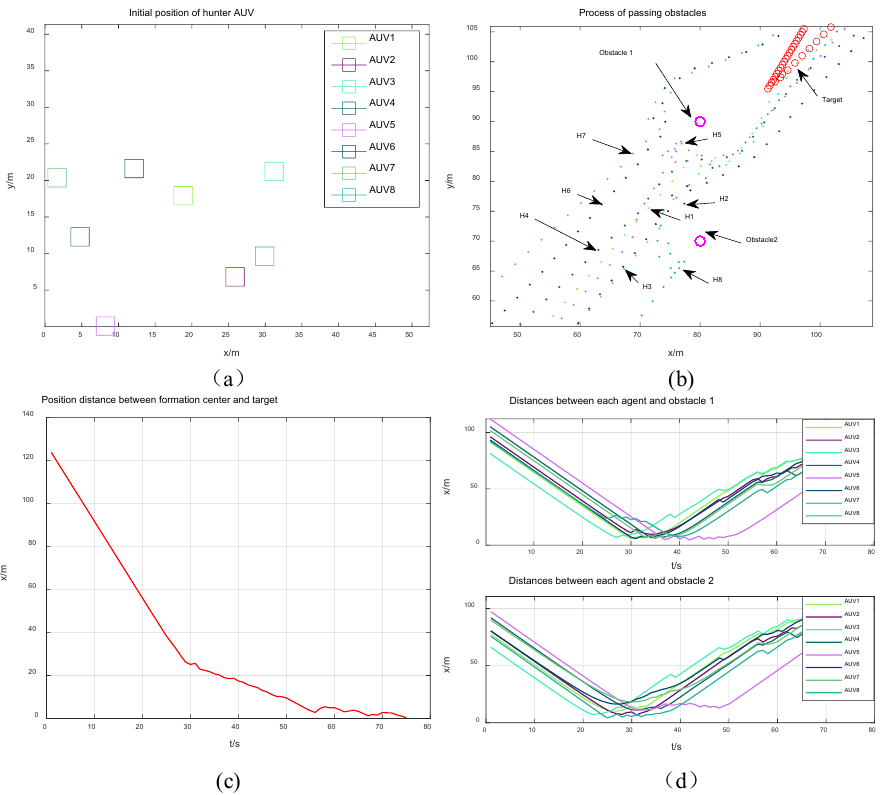
Figure 7. APF-based method in static environment: ( a ) The initial position of hunter AUV; ( b ) process of passing obstacles; ( c ) position distance between formation center and the target; ( d ) distances between each agent and obstacle 1 and 2.